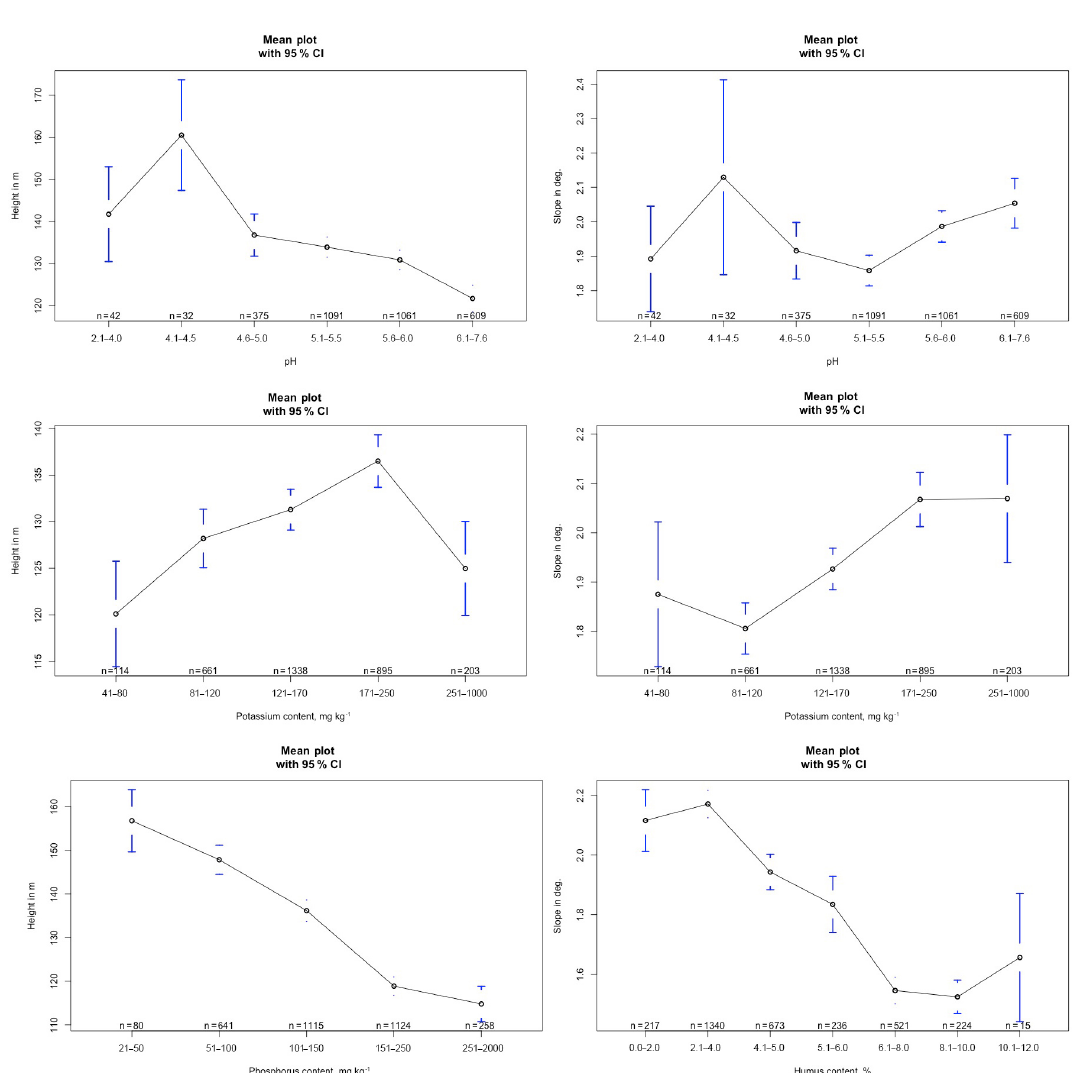
Figure 2. The ANOVA results between the content in the soil of nutrients for plants and the characteristics of the relief.